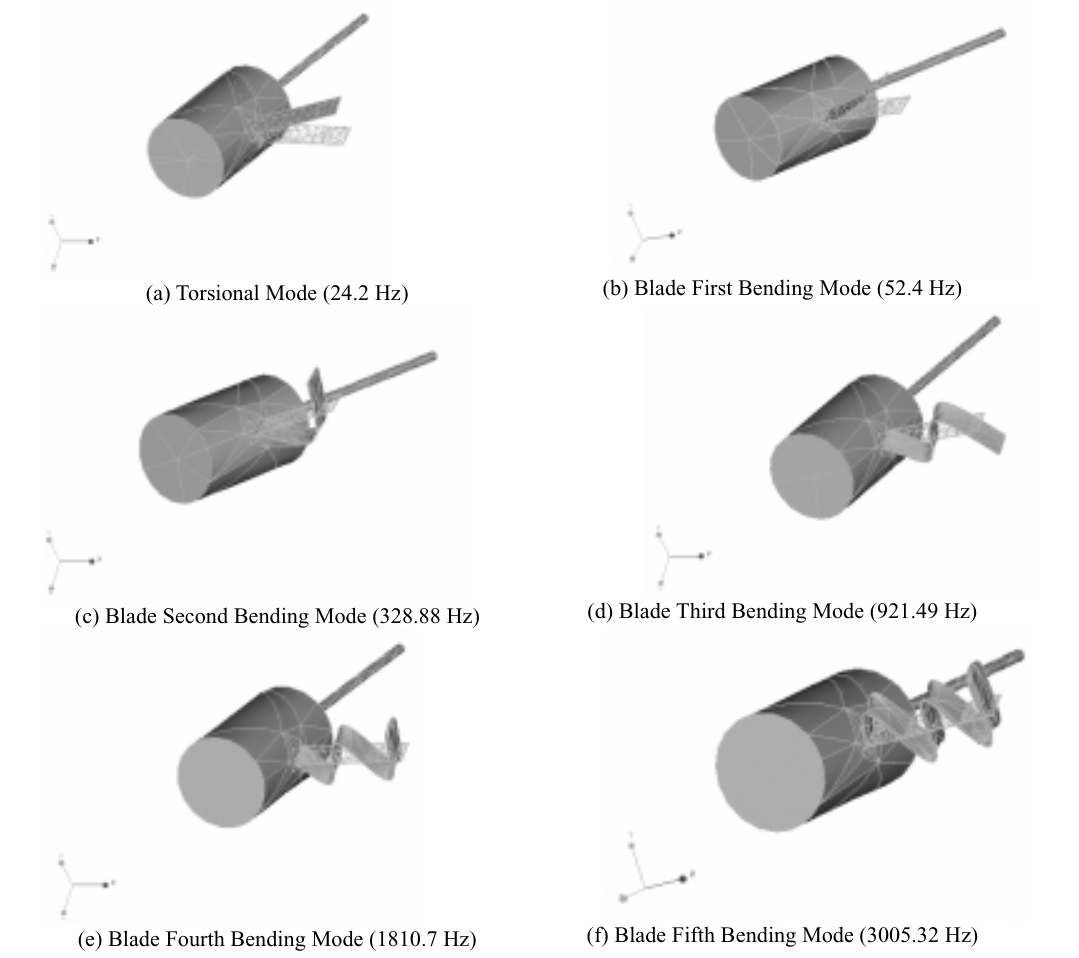
Fig. 12. FEM Model Shaft torsional and blade bending modes for k T = 300 N.m/Rad, β = 30 ◦